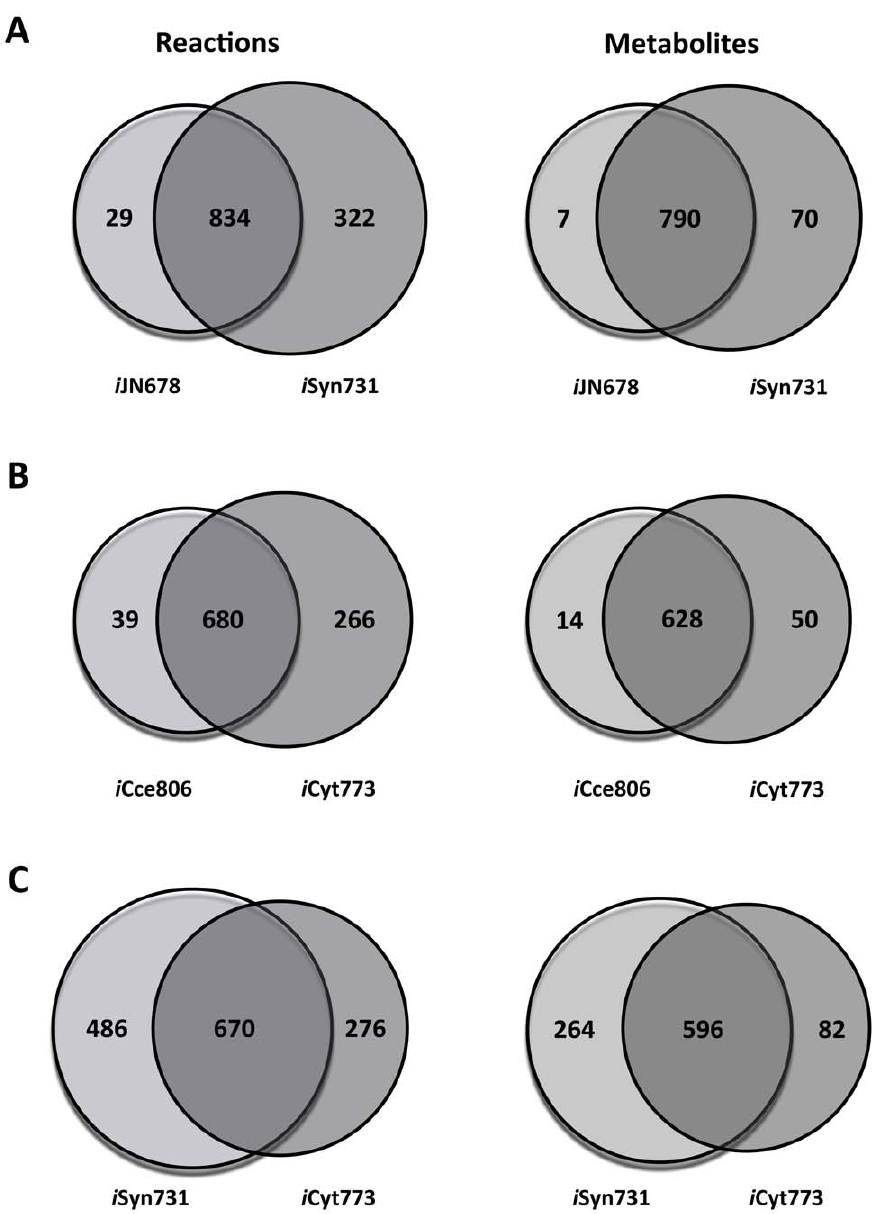
Figure 3. Venn diagram depicting (common and unique) reactions and metabolites between (A) i JN678 [ 32 ] and i Syn731, (B) i Cce806 [ 25 ] and i Cyt773, and (C) i Syn731 and i Cyt773 models. doi:10.1371/journal.pone.0048285.g003 location of the CO 2 fixation (i.e., ribulose-1,5-bisphosphate carboxylase/oxygenase (RuBisCO) enzyme). Literature [69,70] shows that cyanobacteria possess a micro-compartment (i.e., carboxysome) encapsulating RuBisCO and carbonic anhydrase (CA) enzymes. i Syn731 adds carboxysome as a cellular compart-